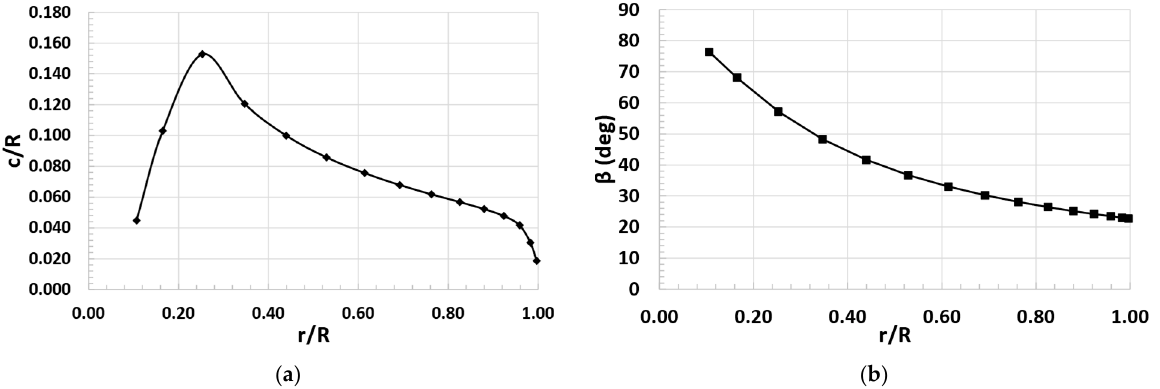
Figure 9. DEP propeller designed with Patterson’s approach. ( a ) Chord distribution. ( b ) Pitch angle distribution. Table 7. Aerodynamic data of M114 and SDA1075 blade airfoil, XFOIL M = 0.15, Re = 3 × 10 6 .